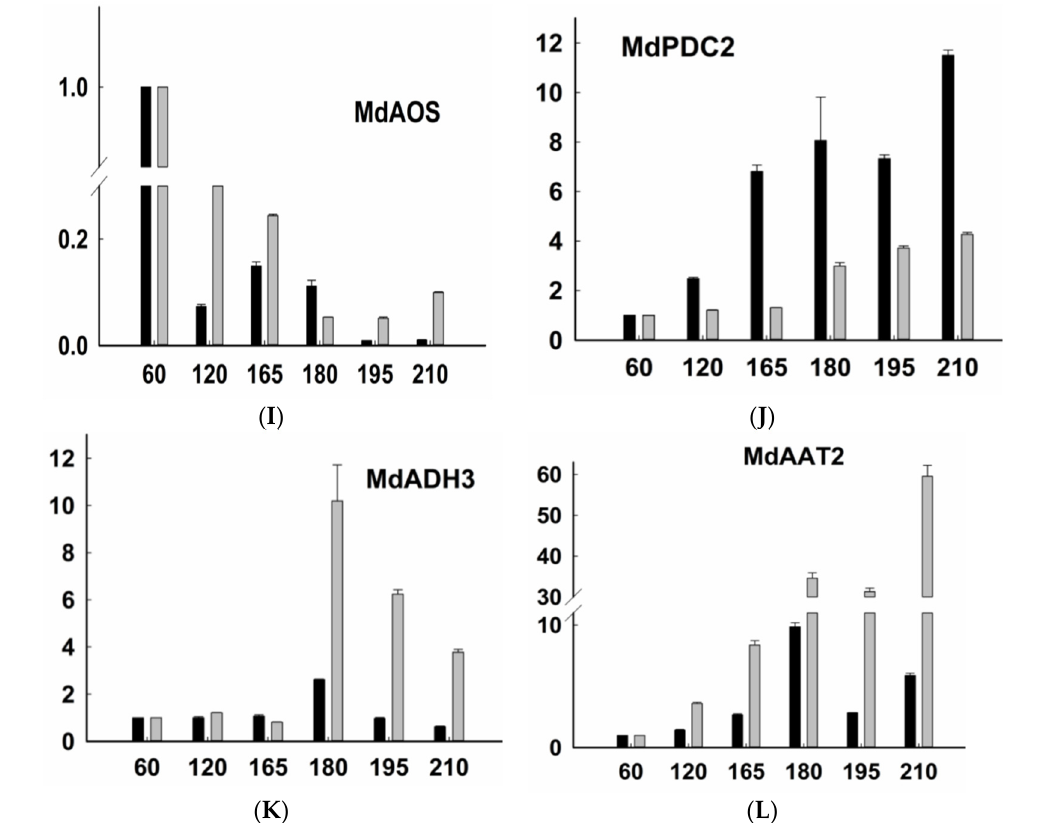
Figure 4. Changes in relative expression levels of 12 genes ( A – L ) related to aroma synthesis in fruit of “Ruixue” and “Fuji” apples during different developmental stages. Values are means ± standard error of three biological replicates.